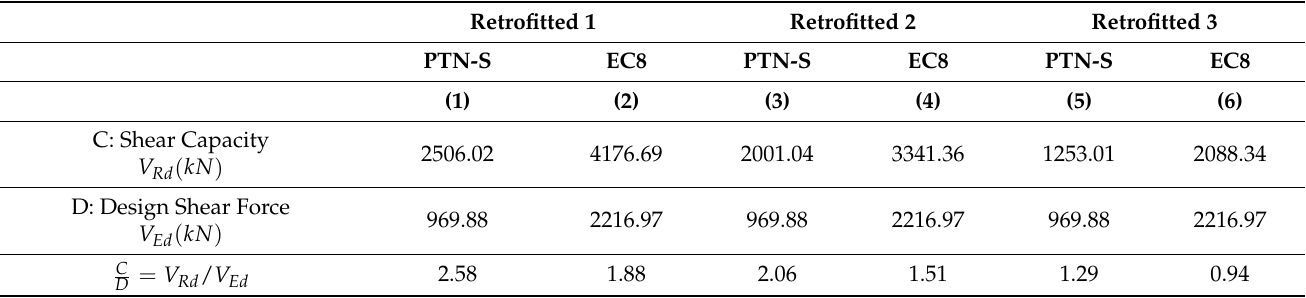
Table 7. Comparison of seismic capacity (C) and demand (D) at the ground floor level of the building in E–W direction (for the retro fi tt ed structure).